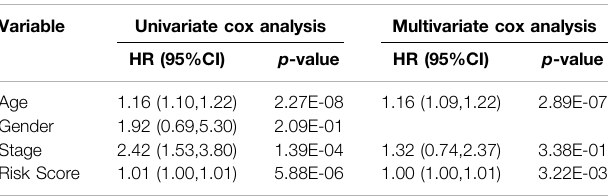
TABLE 3 | Cox regression analysis for clinical characteristics and RS in fl uencing prognosis in THCA patients.